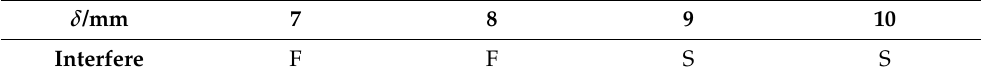
Table 5. Interference results of the value of δ ( ϕ = 20 ◦ , t = 2 mm). F: interfered, S: not interfered.